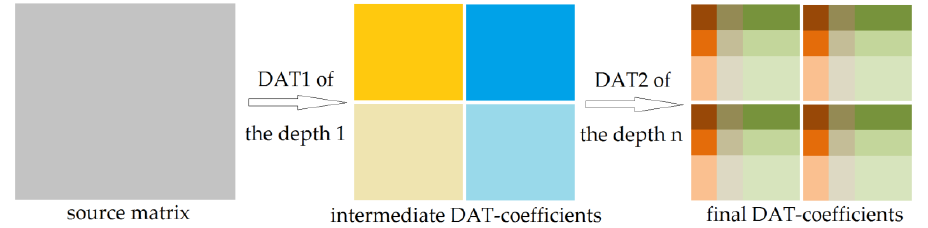
Figure 6. A mixture of DAT1 and